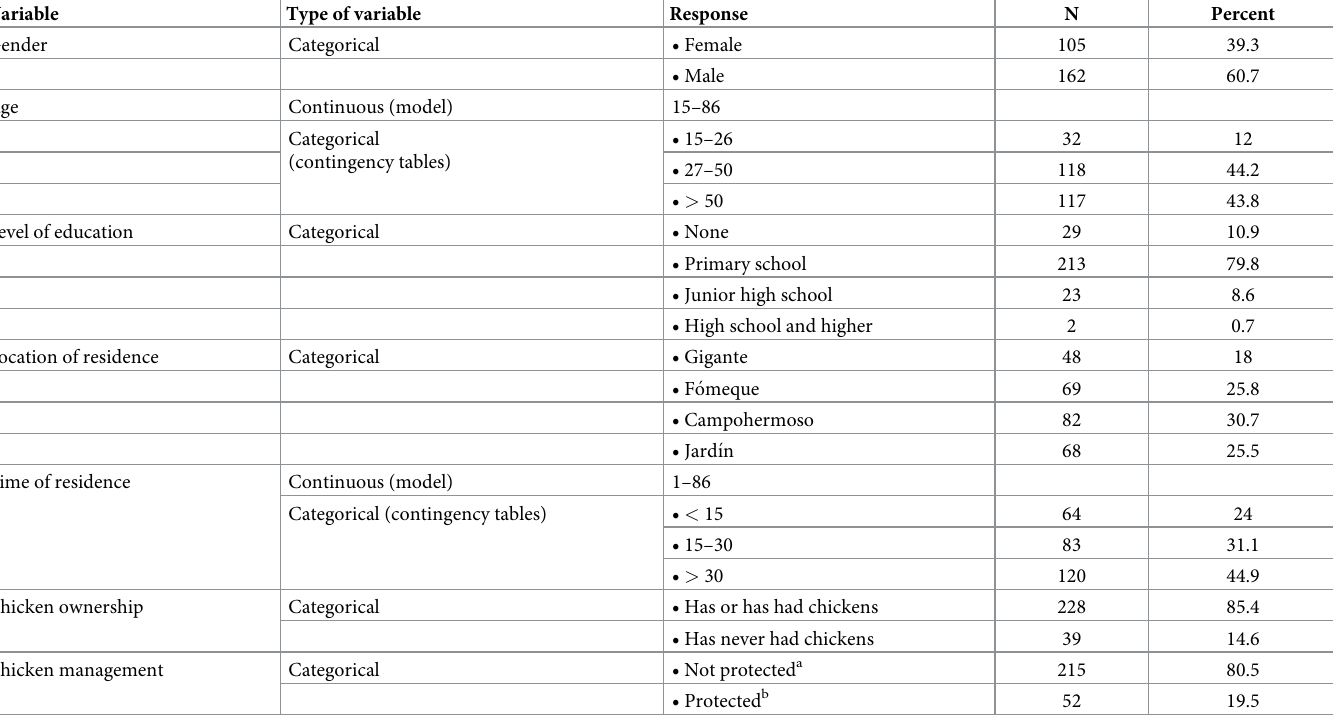
Table 1. Explanatory variables used in the analysis of the perception people have of Spizaetus isidori in Colombia, and the frequency of responses by the